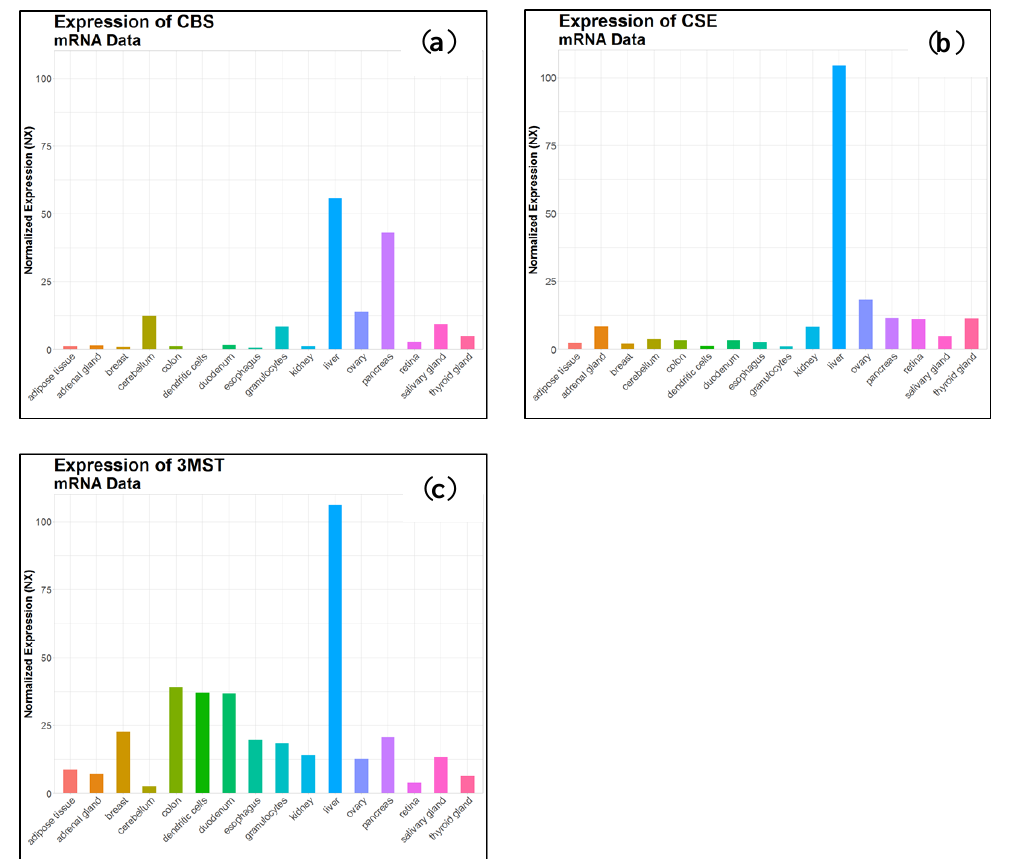
Figure 5. Normalized expression (NX) in different tissues of CBS ( a ), CSE ( b ), 3MST ( c ) ([107]; source data for the plots were downloaded from the Human Protein Atlas, v19.proteinatlas.org) .